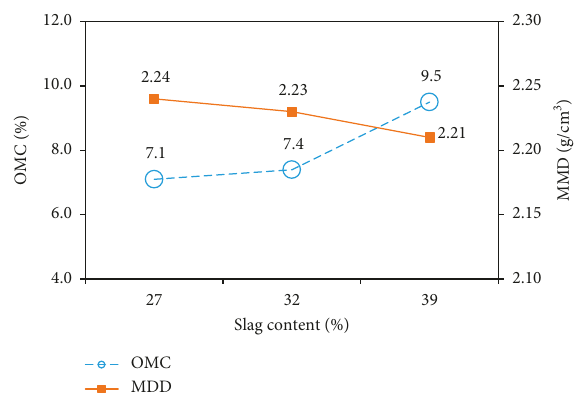
Figure 3: Moisture-density characteristics of CTB.